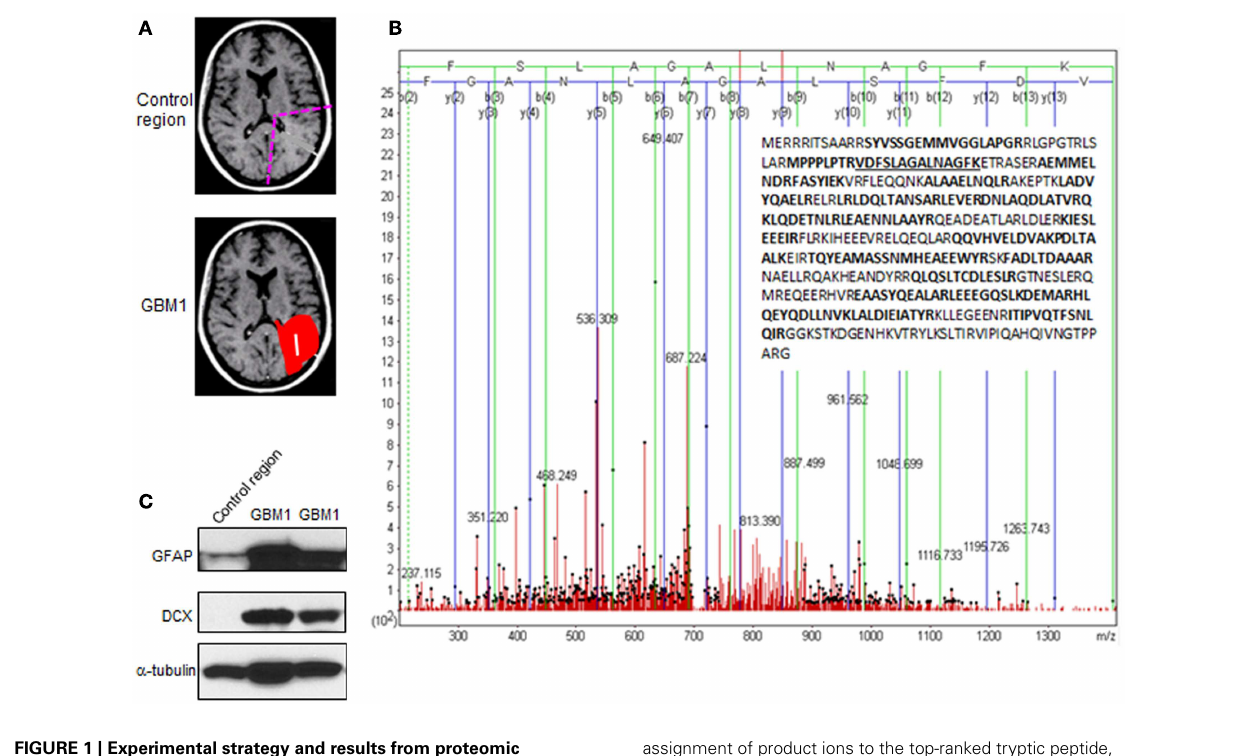
FIGURE 1 | Experimental strategy and results from proteomic screening . (A) Schematic diagram depicting the region of GBM1 specimen for proteomic screening. (B) Glial fibrillary acidic protein (GFAP or E9PAX3_HUMAN), one of the top-ranked proteins shown in Table 1 , was highly expressed in GBM1 vs. normal brain region specimens.The annotated MS/MS spectrum shown illustrates the amino acid sequence